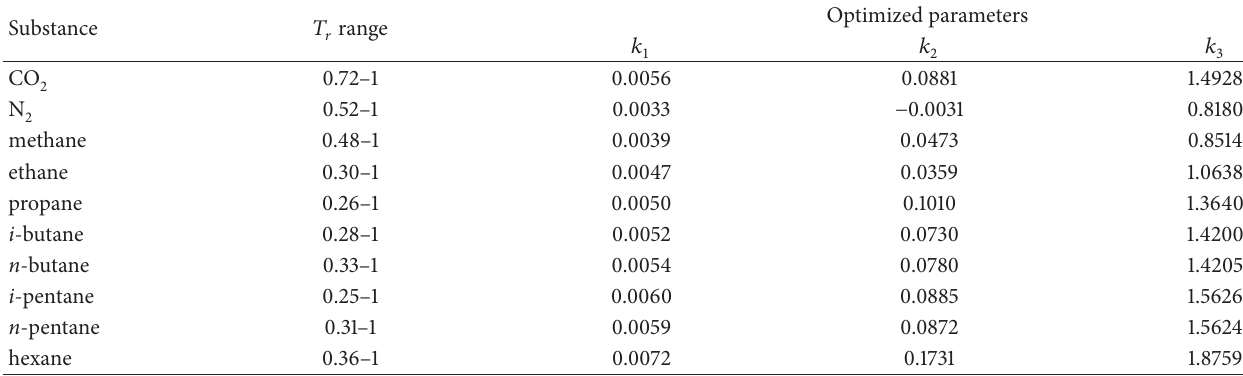
Table 1: Optimized parameters of the new 𝛼 -function proposed by Saffari (3).